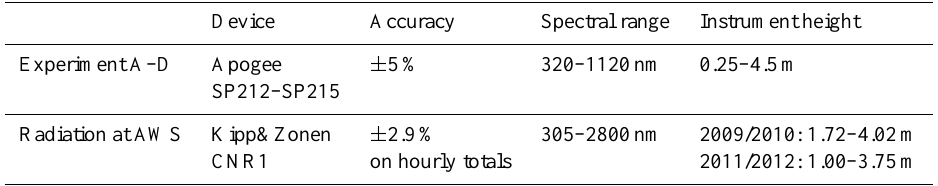
Table 2. Sensor specifications and accuracies. The same type of sensors have been deployed on both AWSs. The instrument heights give minimum and maximum values.